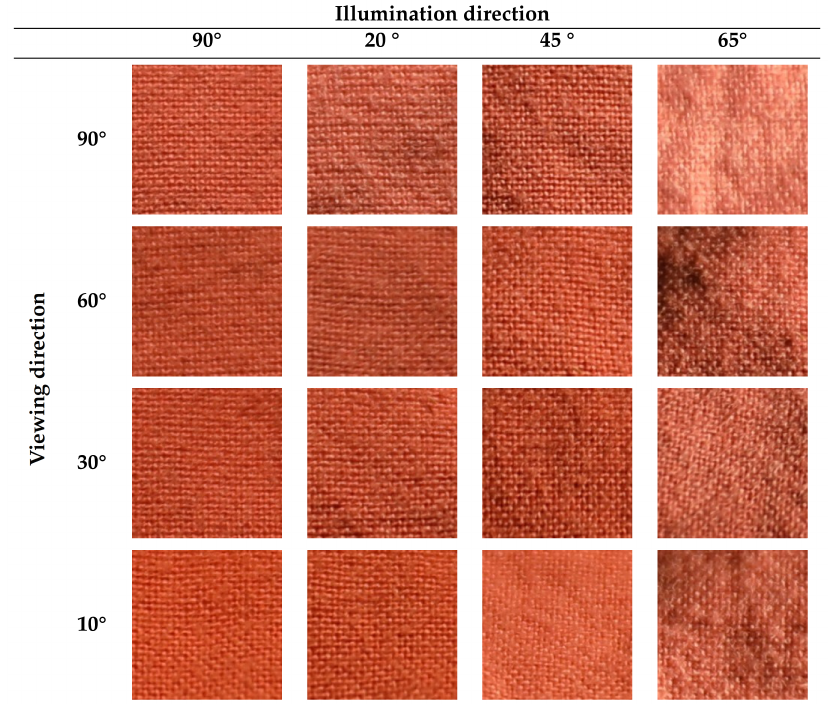
Figure 5. Images of a cotton sample from the UJM TIV dataset observed under different views.